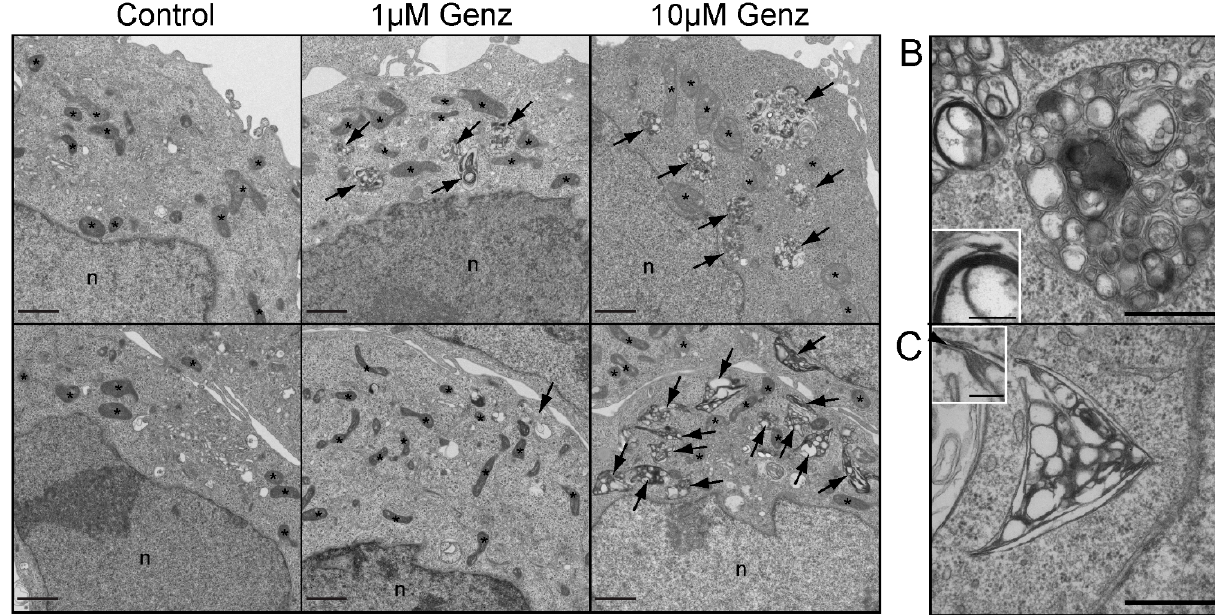
Figure 5. Lovo and HCT116 cells present an elevated number of multivesicular bodies (MVBs) which contain conspicuous structured vesicles upon Genz treatment. ( A ) The number of multivesicular bodies with vesicles displaying multilamellar structures was ele- vated in Genz-treated colon carcinoma cells. MVB-number increased markedly with 1 µM Genz in Lovo cells. Only low numbers of MVBs were seen in HCT116 cells upon treatment with 1 µM Genz. The numbers of MVBs rose markedly with higher Genz concen- trations; scale bars, 1 µm. ( B ) Vesicles inside MVBs of Lovo cells were canonically spheroid, with potential to form onion-like super- structures and myelin-like compaction of stacked membranes ( B , insert). ( C ) MVBs of HCT116 cells displayed angular overall shapes (here triangular), a combination of apparently stiff sheets with sharp cornered rims. The insert demonstrates a widening of the ex- pectedly lipophilic middle-leaflet of the canonical bi-laminar unit-membrane (arrowhead), scale bars in ( B , D ), 500 nm; in insets 100 nm. ( D ) The number of MVBs increased with elevated Genz-concentrations; shown are mean numbers of MVBs per µm 2 cytosol, each from 10 cells. ( E , F ) The expression levels of the autophagy marker Lc3-II rose markedly in both Lovo- ( E ) and HCT116 cells ( F ) upon increased Genz concentrations; significances are *, p ≤ 0.05; **, p < 0.01; ***, p < 0.001. 2.6. GSL-Synthesis Inhibition by Miglustat or Ugcg-gRNA Did Not Cause Intra-Lysosomal Lipid Accumulation In contrast to the Genz-treated cells, a lysosomal accumulation of lipids was not ob- served upon Miglustat- (Figure S7A,B) or Ugcg -gRNA treatment (Figure S7C,D) of Lovo- (Figure S7A,C) and HCT116 cells (Figure S7B,D).